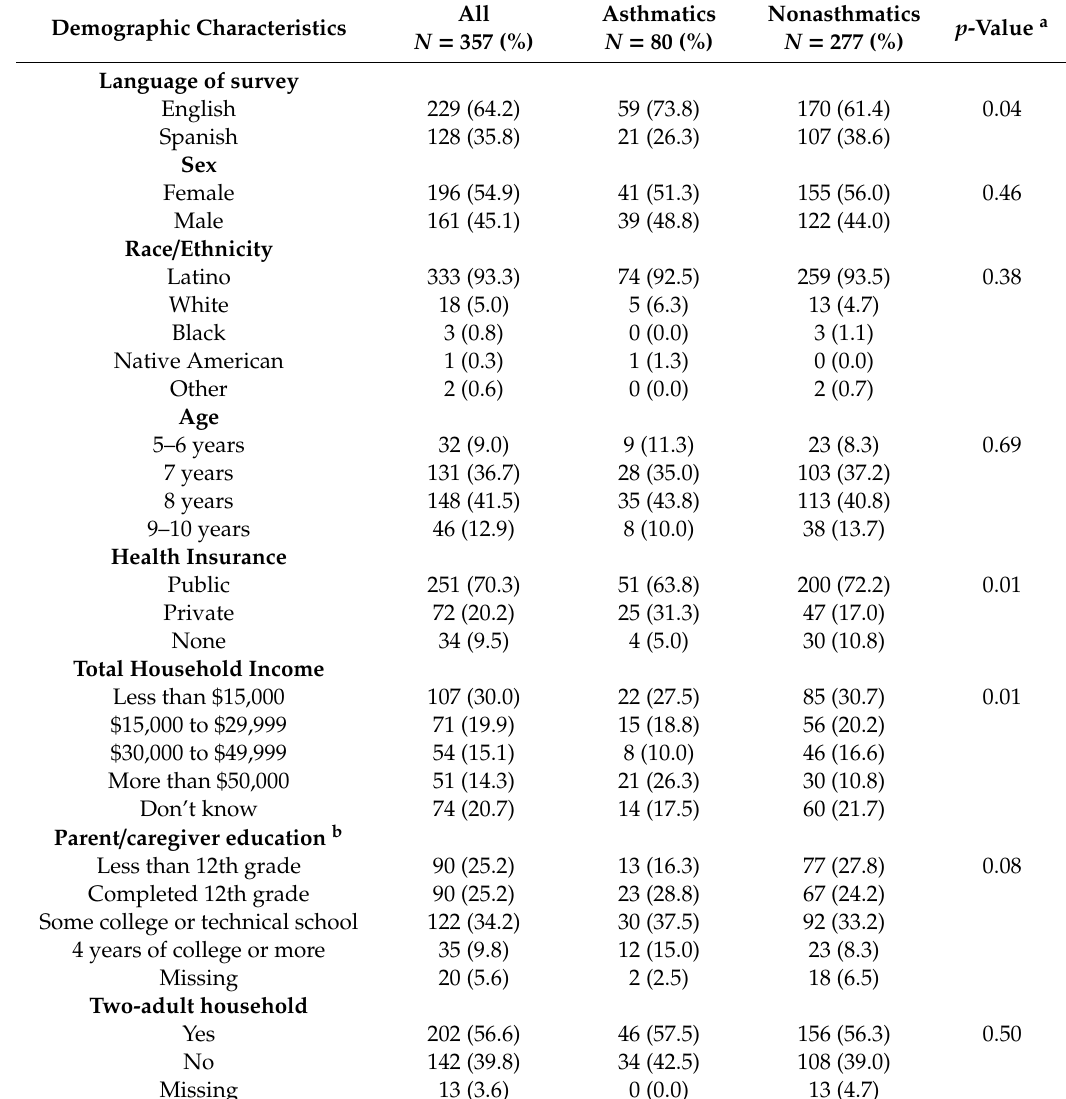
Table 1. Demographic characteristics of asthmatic and nonasthmatic study participants ( N = 357). Demographic